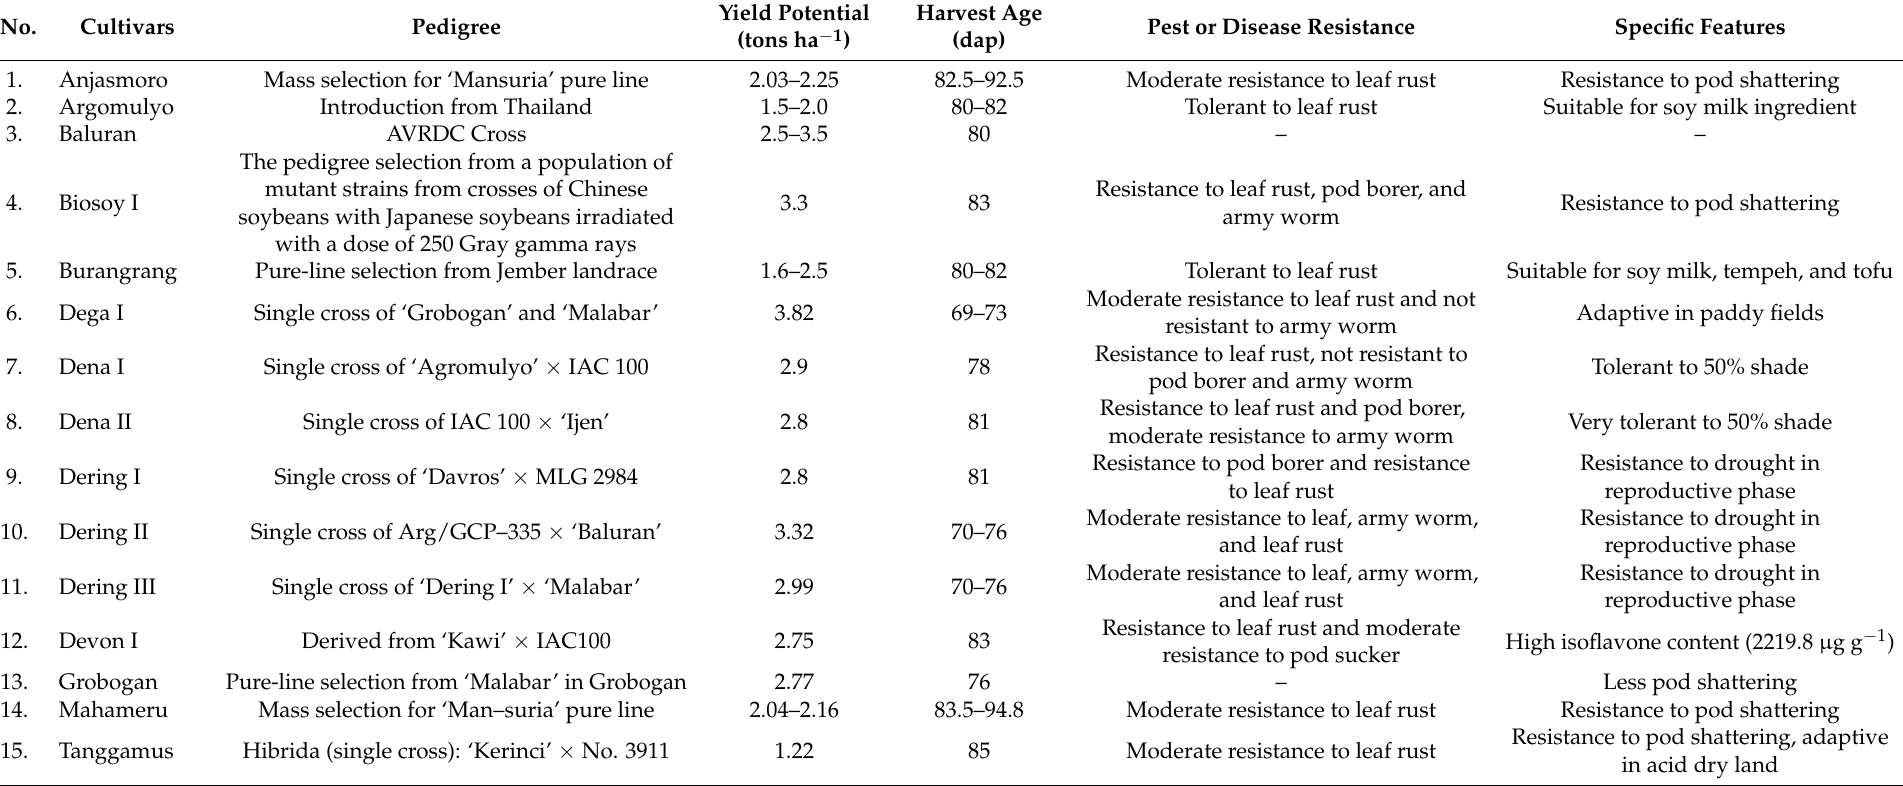
Table 2. Fifteen evaluated soybean cultivars (with some